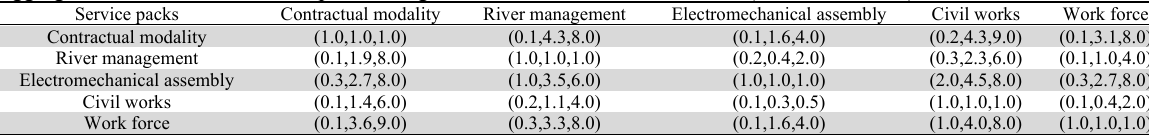
Table 3 Aggregated matrix for the service packs using the maximum-minimum method (arithmetic